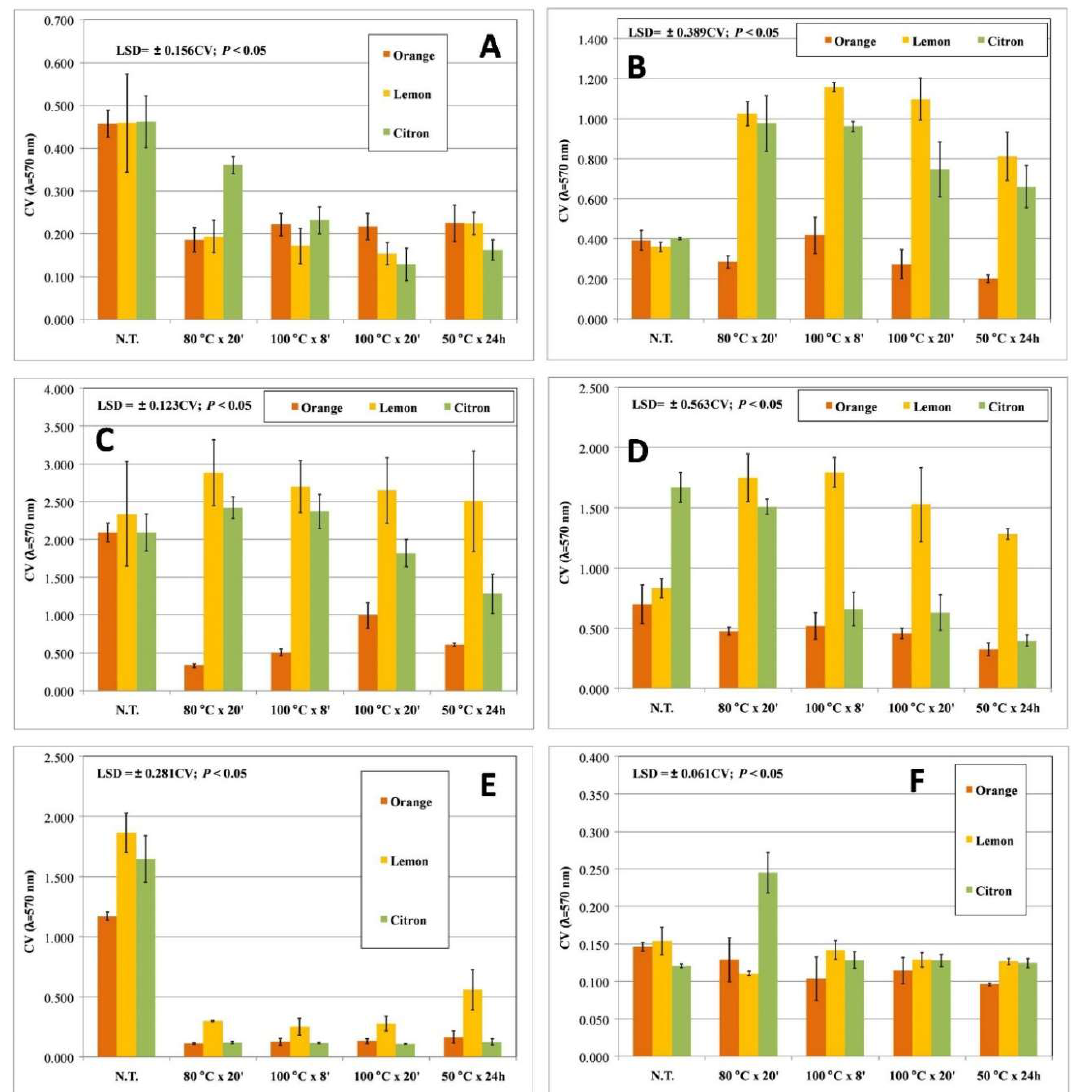
Figure 3. Biofilm biomass produced by P. fluorescens NCPPB 1964 ( A ), P. fluorescens 84094 ( B ), P. fluorescens ITEM 17298 ( C ), P. fluorescens ITEM 17299 ( D ), P. putida ITEM 17297 ( E ), and E. coli K12 ( F ) in the presence of different citrus peel water extracts. Mean values (bars ± standard deviation) from the same strain were compared by Fisher’s least significant difference (LSD) multiple-comparison test (95% Confidence Intervals); N.T.: not treated.